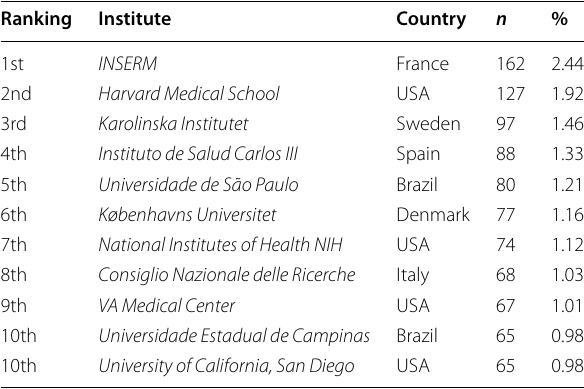
Table 1 A list of the top ten institutions that published research on insulin resistance and obesity from 2002 to 2021 Ranking